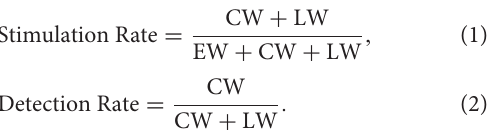
Frontiers in Neuroscience |